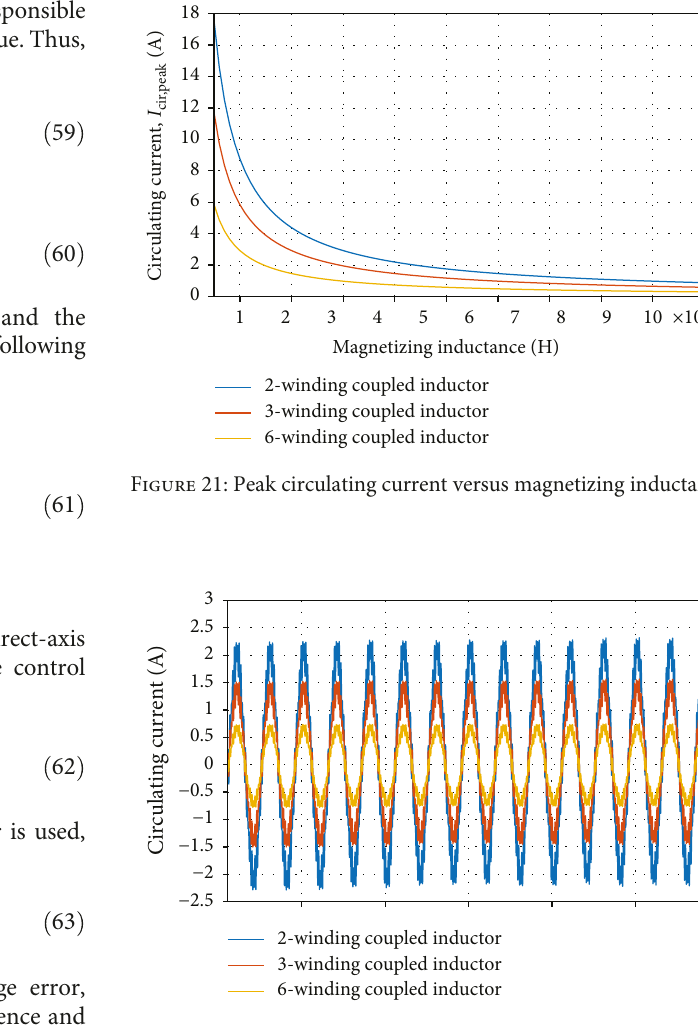
Figure 22: Circulating current inside the HMC with multiwinding coupled inductors.